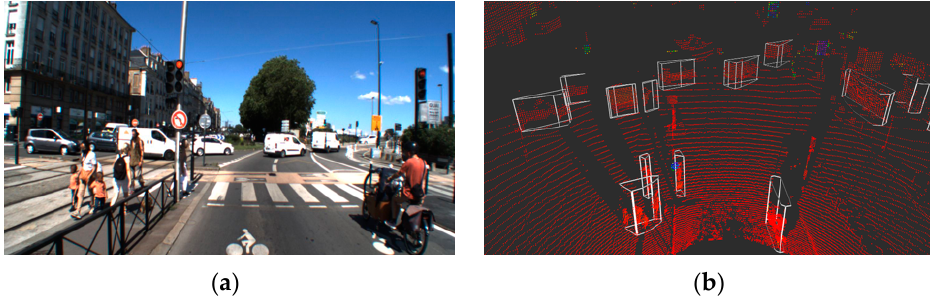
Figure 8. Clustering analysis: ( a ) camera image for illustration and ( b ) results of lidar clustering detection.